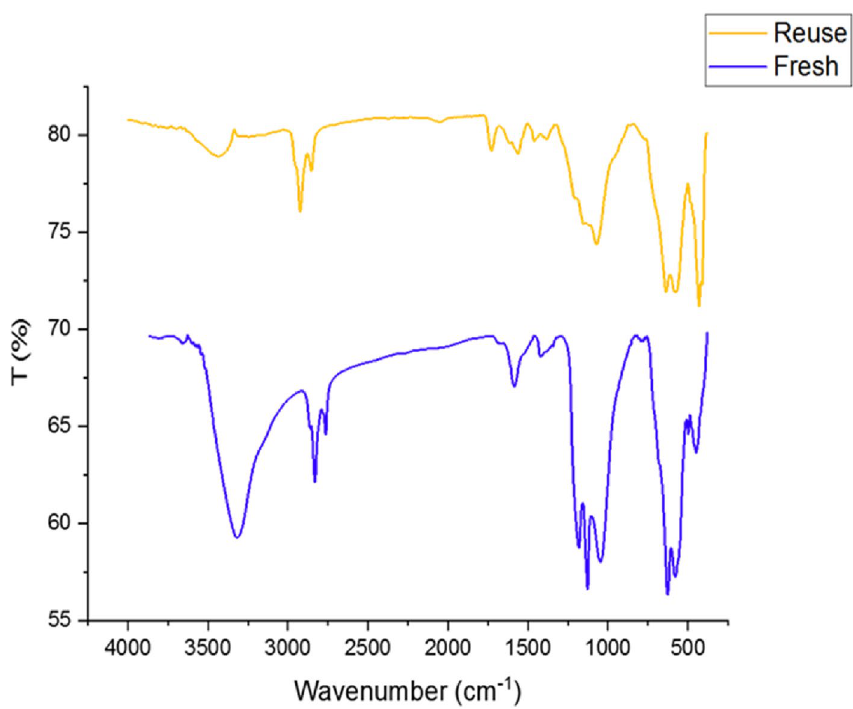
Figure 16. FT-IR spectra of fresh (blue) and reuse (orange) of Fe 3 O 4 @SiO 2 -Im[Br]-SB-Cu (II)